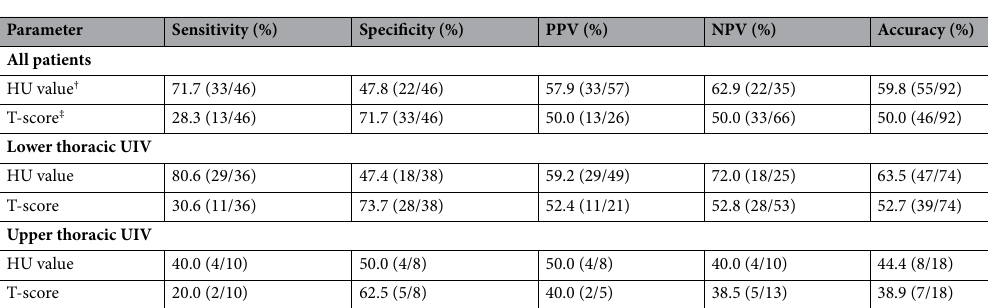
Table 3. Sensitivity, specificity, PPV, NPV, and accuracy of HU value and T-score for prediction of screw loosening. PPV positive predictive value, NPV negative predictive value, HU Hounsfield unit, UIV